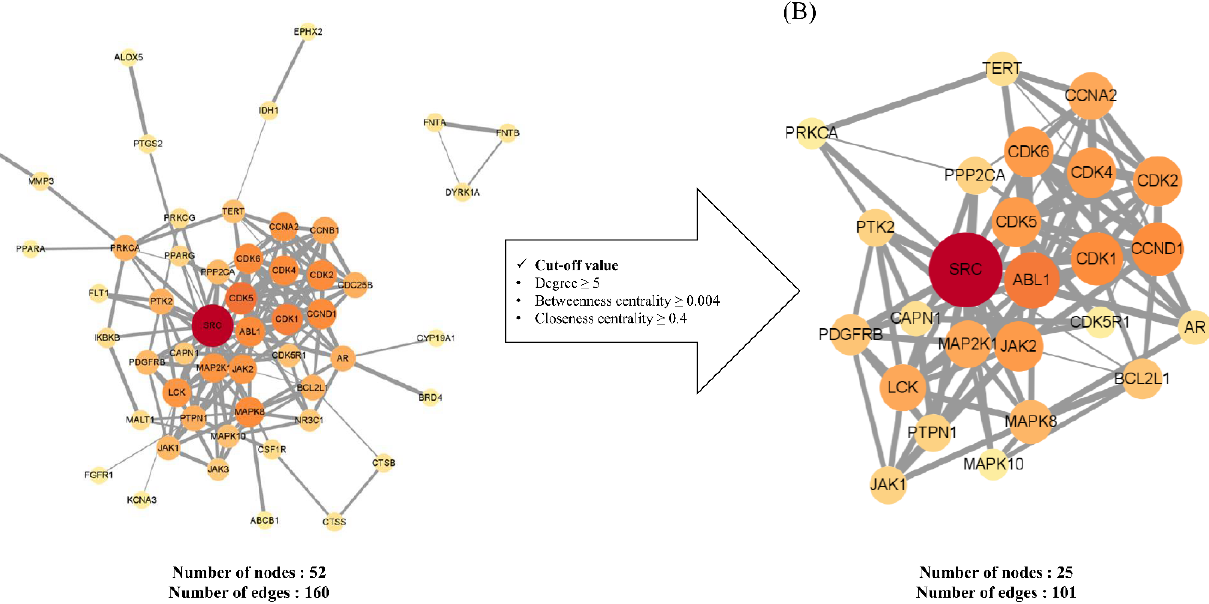
Figure 2. Protein–protein interaction (PPI) networks: ( A ) A PPI network of potential targets; ( B ) A PPI network of the key targets. The size and the red hue of a node denote its significance within the network . Table 2. A list of key targets based on protein – protein interaction network topological analysis.